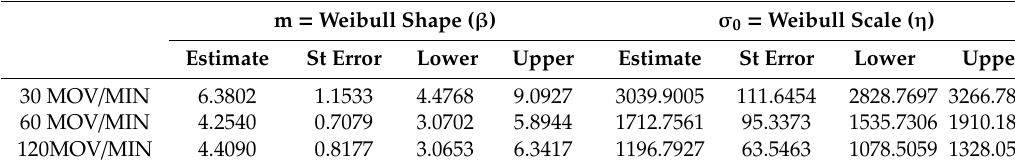
Table 5. Weibull statistics of the NCF.